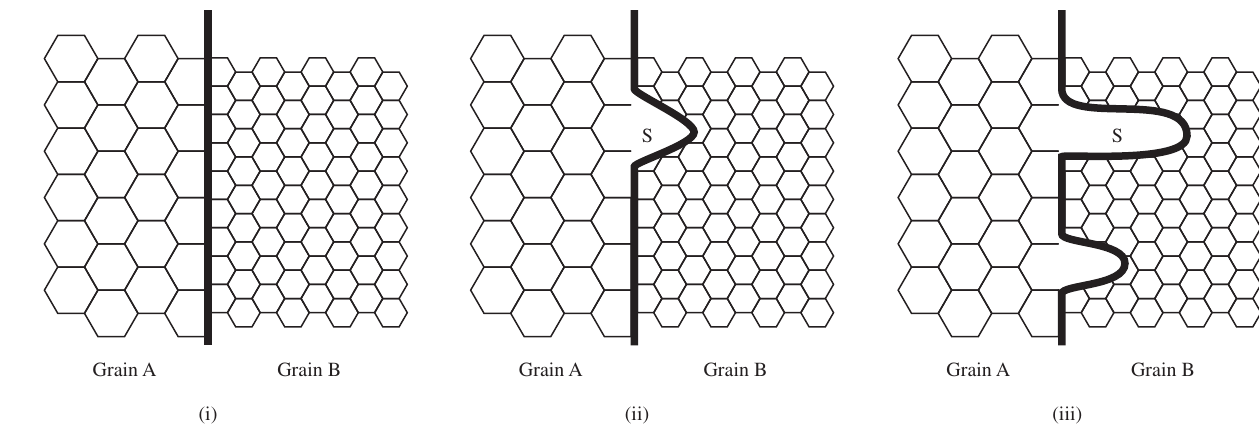
Figure 1. Schematic representation of nucleation by migration of boundaries induced by deformation 58